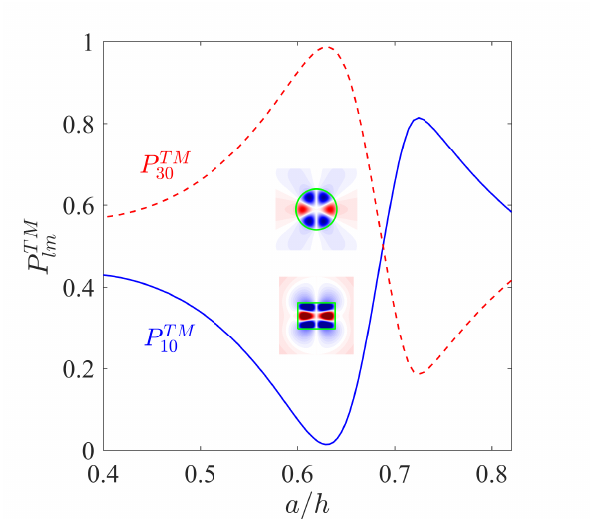
Figure 11. Evolution of the multipole TM powers from disk vs the aspect ratio for the case shown in Figure 7.